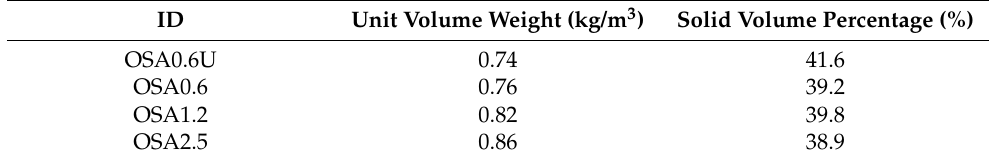
Table 4. Unit volume weight and solid volume percentage.